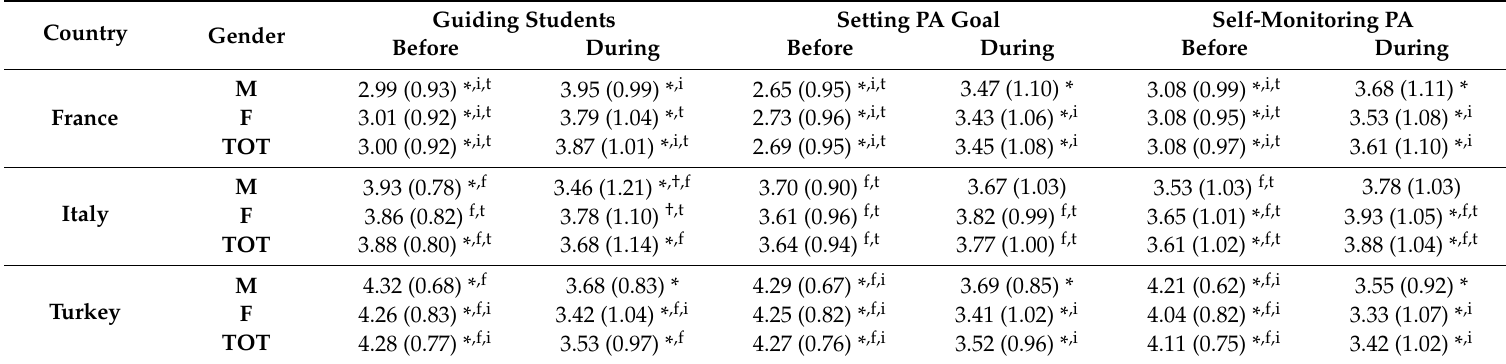
Table 2. Descriptive statistics and Bonferroni post-hoc pairwise comparisons of the interactions time × country × gender in the three teachers’ behaviors promoting students’ out-of-school PA. Guiding Students Setting PA Goal Self-Monitoring PA Country Gender Before During Before During Before